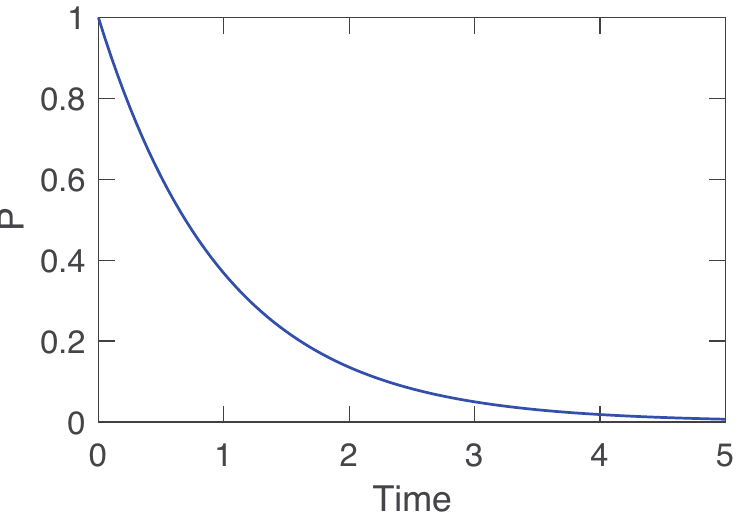
Figure 3. Simulation of the SBML model for the decay model. This model was created by KinModGPT with text-davinci-003